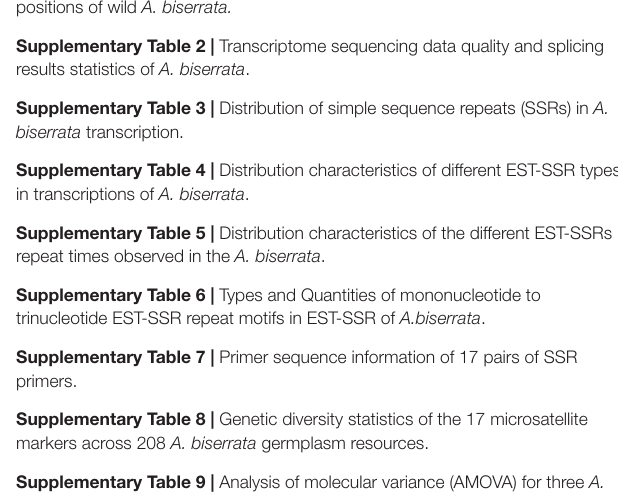
Supplementary Table 9 | Analysis of molecular variance (AMOVA) for three A. biserrata populations. Supplementary Table 10 | The matrix of pairwise genetic differentiation (Fst) among three A. biserrata populations. Supplementary Table 11 | Method validation of the HPLC analysis in Duhuo